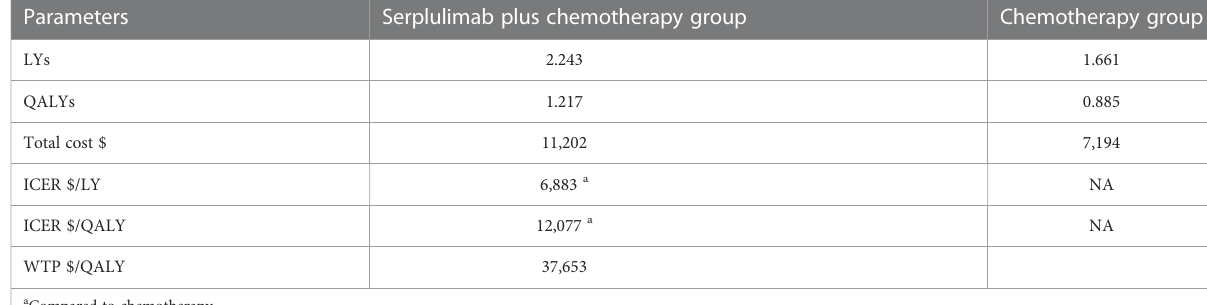
TABLE 2 Baseline results.